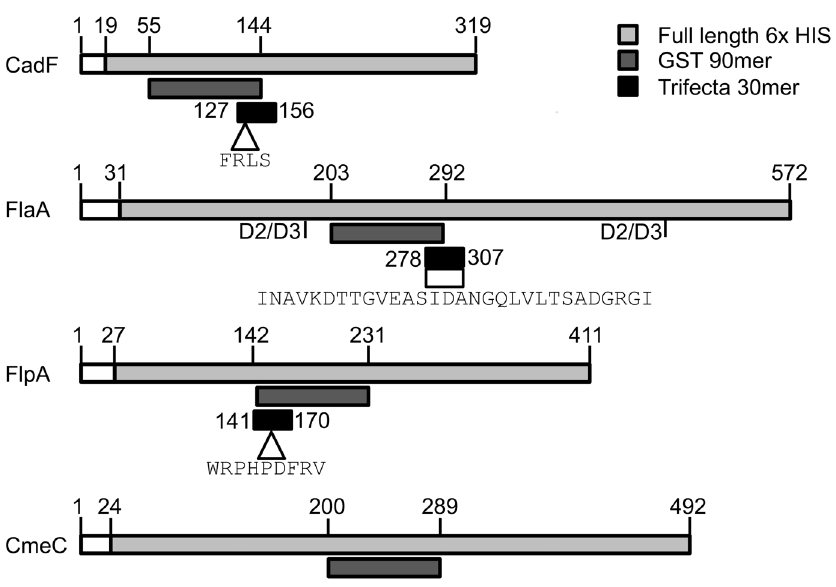
Figure 1. Domains of the C. jejuni proteins targeted for vaccination. The residues of CadF, FlaA, FlpA, and CmeC used for vaccination of chicks are shown above the diagram for each peptide. The portions used for the 6X His-tagged peptides are shown in light gray, the GST-tagged 90 mer fragments are shown in dark- gray, and the 30 mer peptides used to create the trifecta peptide are shown in black. The signal peptides (CadF, FlpA, and CmeC) or sequences required for Type 3 secretion (FlaA) were excluded from the 6X His- tagged peptides, and are shown in white. The arrows under the diagrams for CadF and FlpA indicate residues determined to be required for adherence to fibronectin. The box under the FlaA diagram represents the area chosen to create a synthetic FlaA 30 mer peptide based on the consensus sequence shown below. This region falls within the borders of the D2 and D3 domains of FlaA, which are predicted to be surface-exposed in the native protein. The 90 mer region chosen for CmeC falls within a hydrophilic region of the protein that is predicted to be surface-exposed.